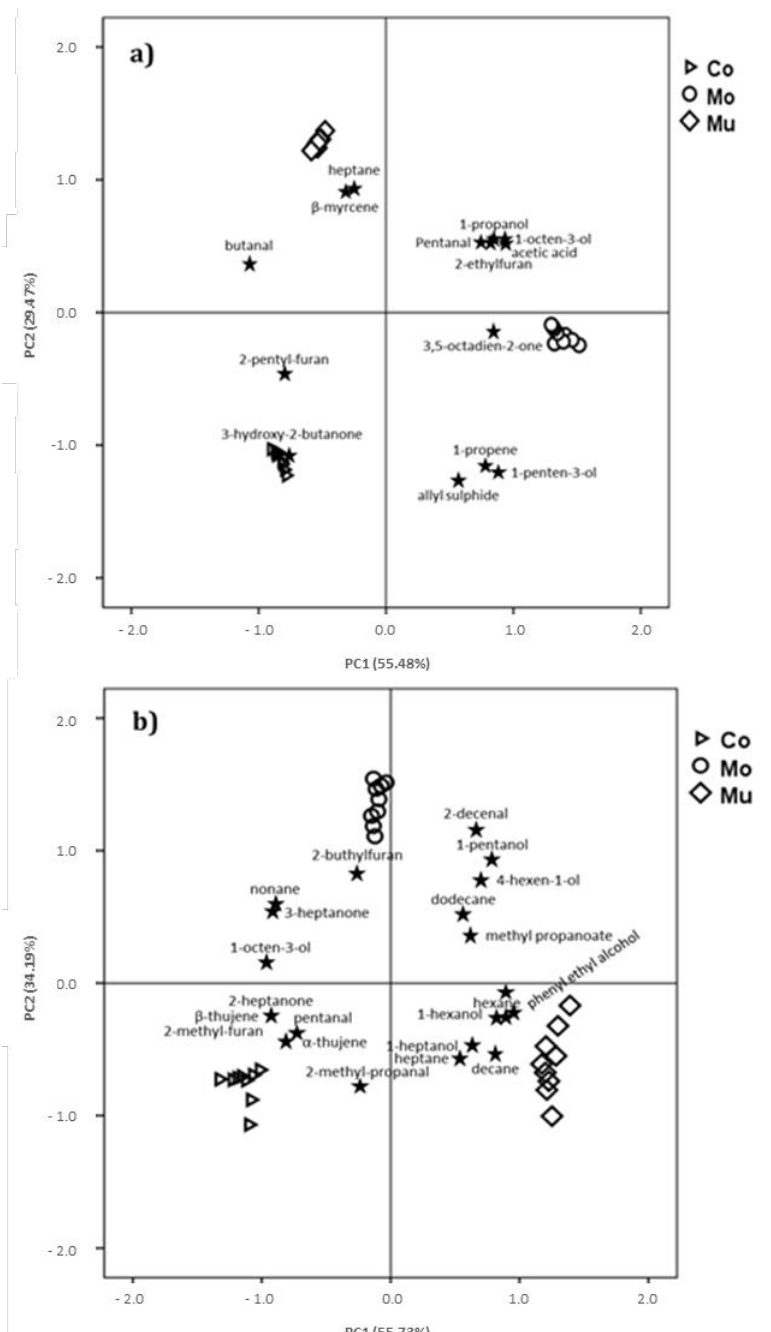
Figure 3. Principal component analysis (PCA) of the significant volatile compounds in dry-cured ( a ) and cooked ( b ) sausages. The plots represent, for the two first principal components, the loading of each volatile compound and the average scores of each one of batches. Control ( ⪧ ); enriched with monolayered fish oil microcapsules (Ο); enriched with multilayered fish oil microcapsules (◊).